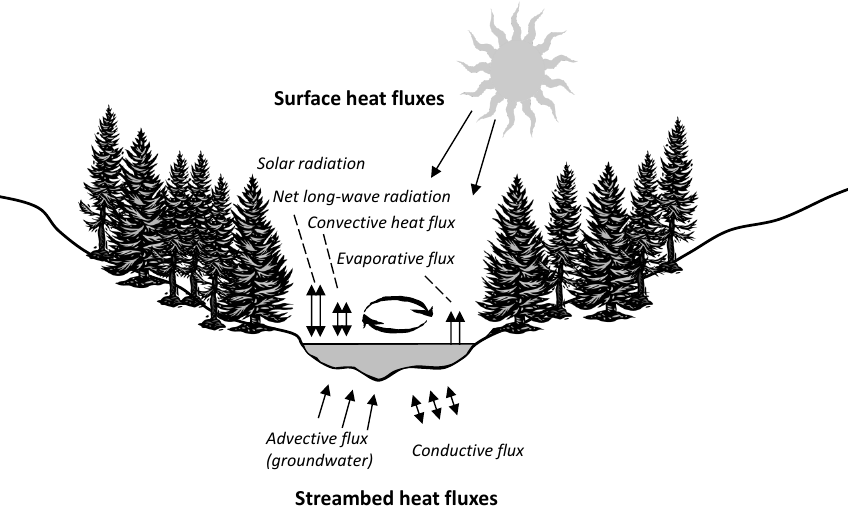
Figure 1. Heat fluxes at the water surface and streambed for the cross section of a gaining stream or river (modified from Caissie, 2006).